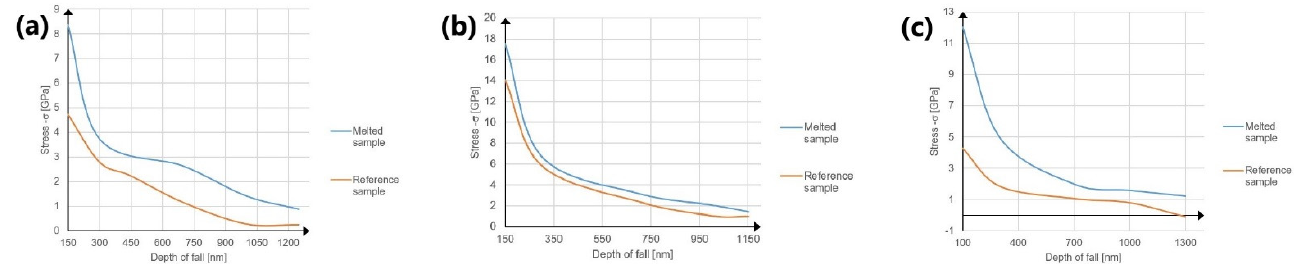
Figure 13. Depth of fall in ( a ) pure titanium (grade IV Ti), ( b ) Ti-6Al-4V alloy and ( c ) Ti-13Nb-13Zr alloy.